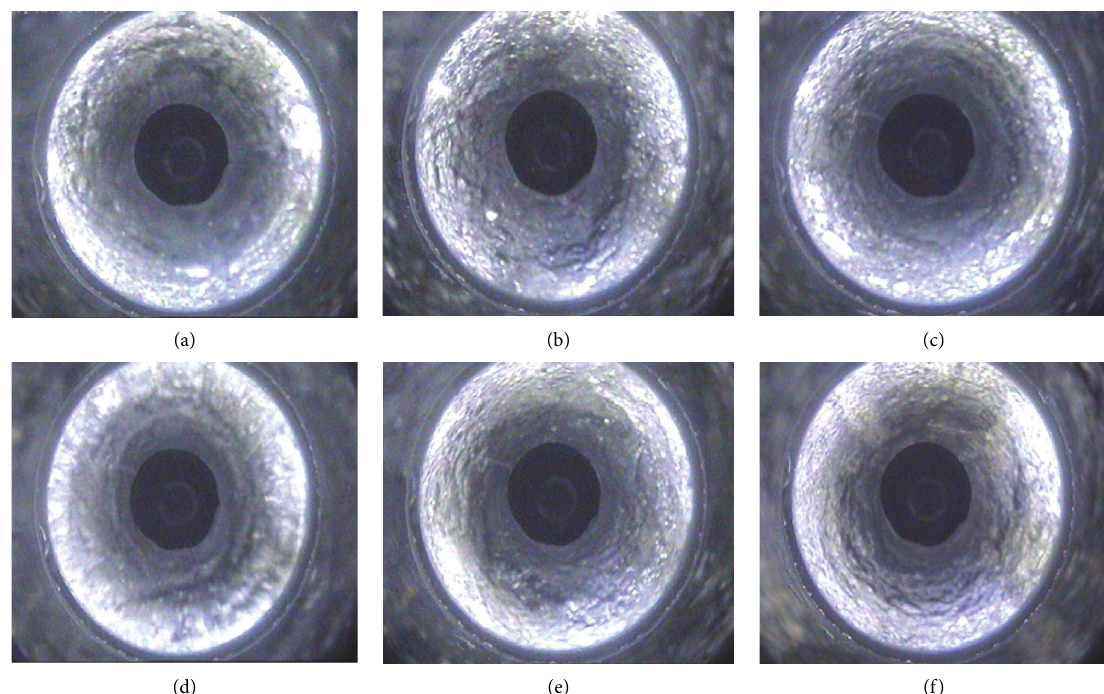
Figure 3: Drilling peep results of 30503 repaired roadway roof. (a) Cracks at 2.9m in no. 01 borehole. (b) Cracks at 3.4m in no. 02 borehole. (c) Cracks at 5.4m in no. 03 borehole. (d) Cracks at 1.5 m in no. 04 borehole. (f) Cracks at 2.5m in no. 04 borehole. (e) Cracks at 6.5m in no. 05